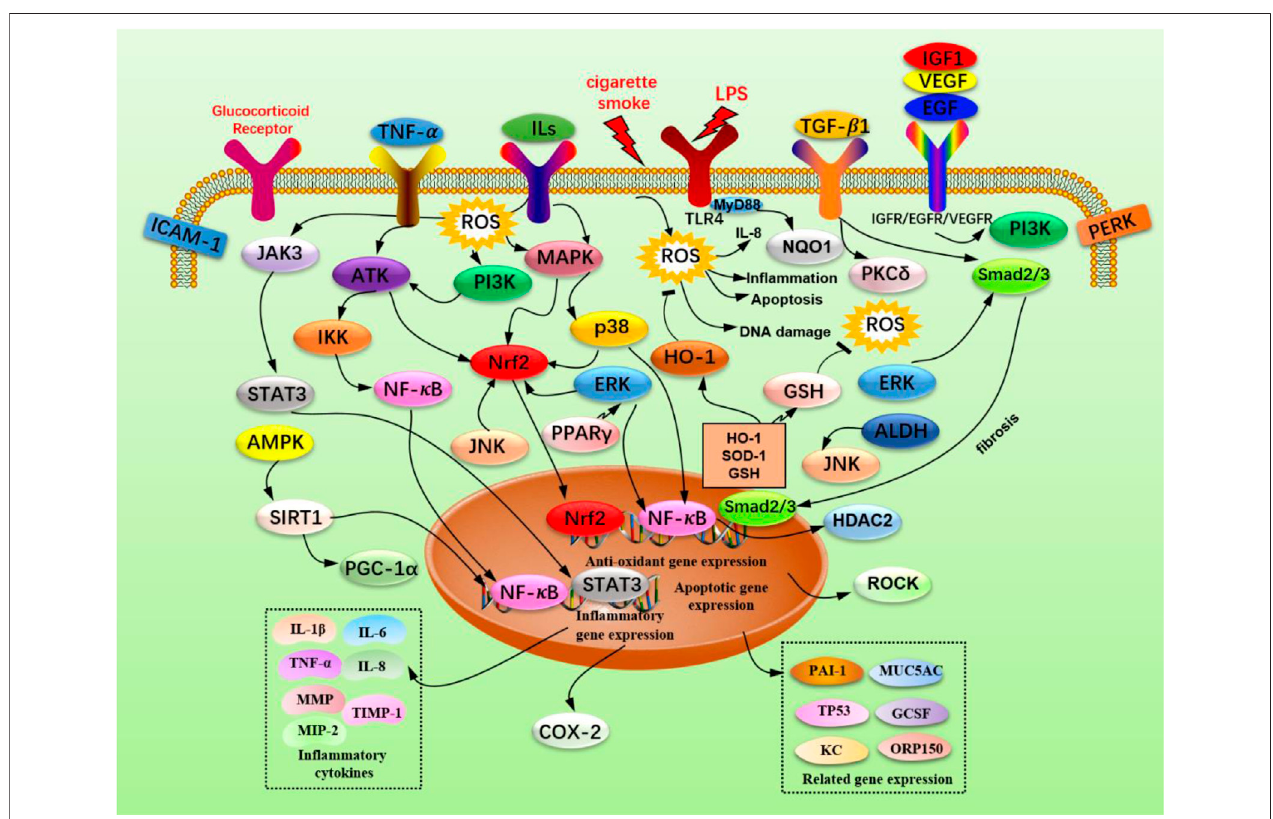
FIGURE 3 | The signaling pathways of natural small molecular compounds in the treatment of COPD.